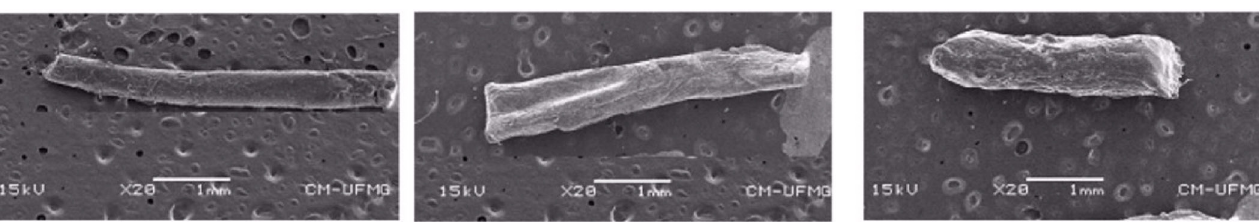
FIGURE 5 - SEM images of the external surface of CA-loaded PLGA implants: (A) before (B) 15 days and (C) 30 days of release study. Magnification of 20x.